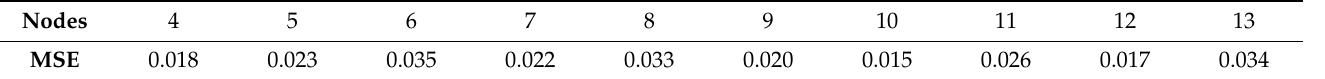
Table 6. MSE of different hidden-layer